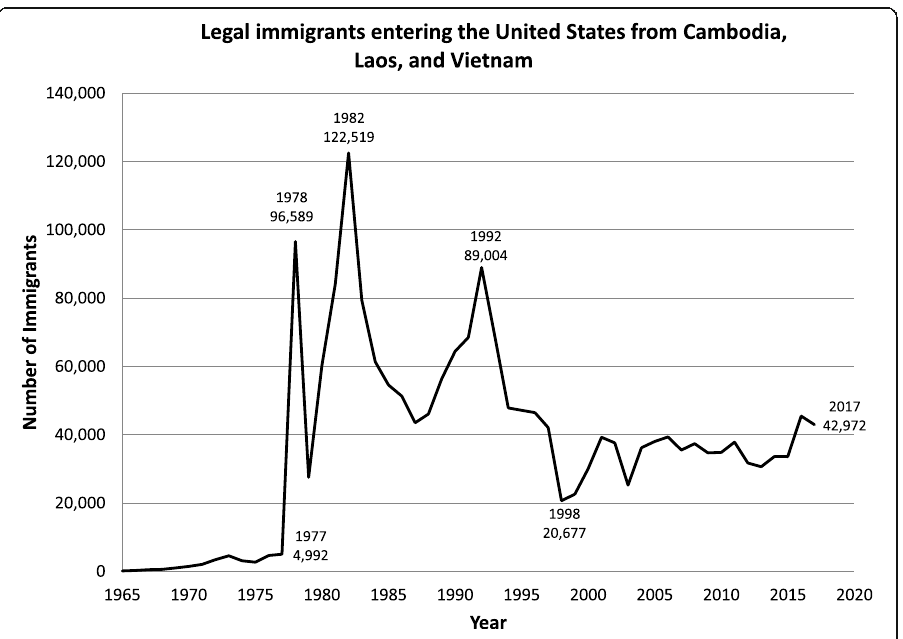
Fig. 22 Legal immigrants entering the United States from Cambodia, Laos, and